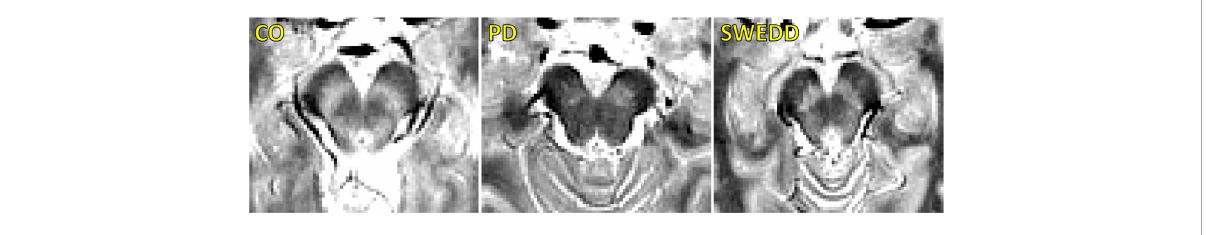
FIGURE2 A comparison of neuromelanin-sensitive contrast from the first echo of the TSE acquisition in controls (left) , PD (middle) , and SWEDD (right) subjects. The PD subject exhibits a loss of contrast as compared to the control and SWEDD